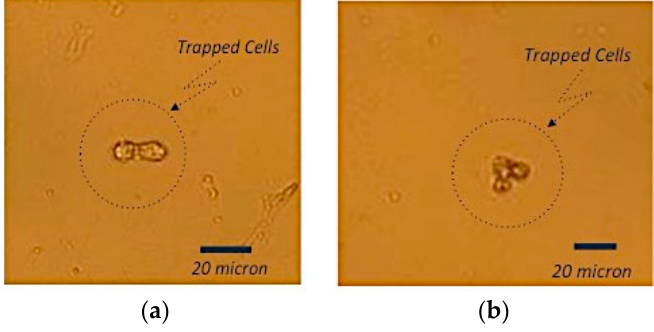
Figure 7. Optical microscopic characterization results: optical microscopic image of apta-DS after introducing target cancer cells with ( a ) two and ( b ) three HCT 116 cells trapped by apta-DS. The scale bar under each SEM image shows that the actual size of HCT 116 is around 10 µm diameter.